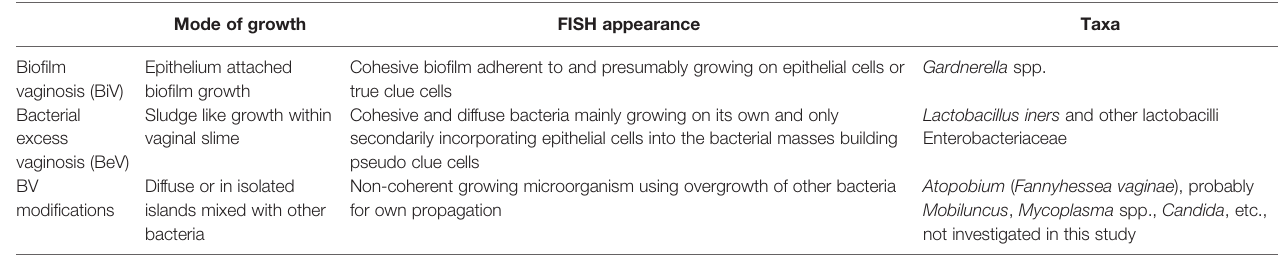
TABLE 2 | Morphological forms of bacterial vaginosis (BV) based on this